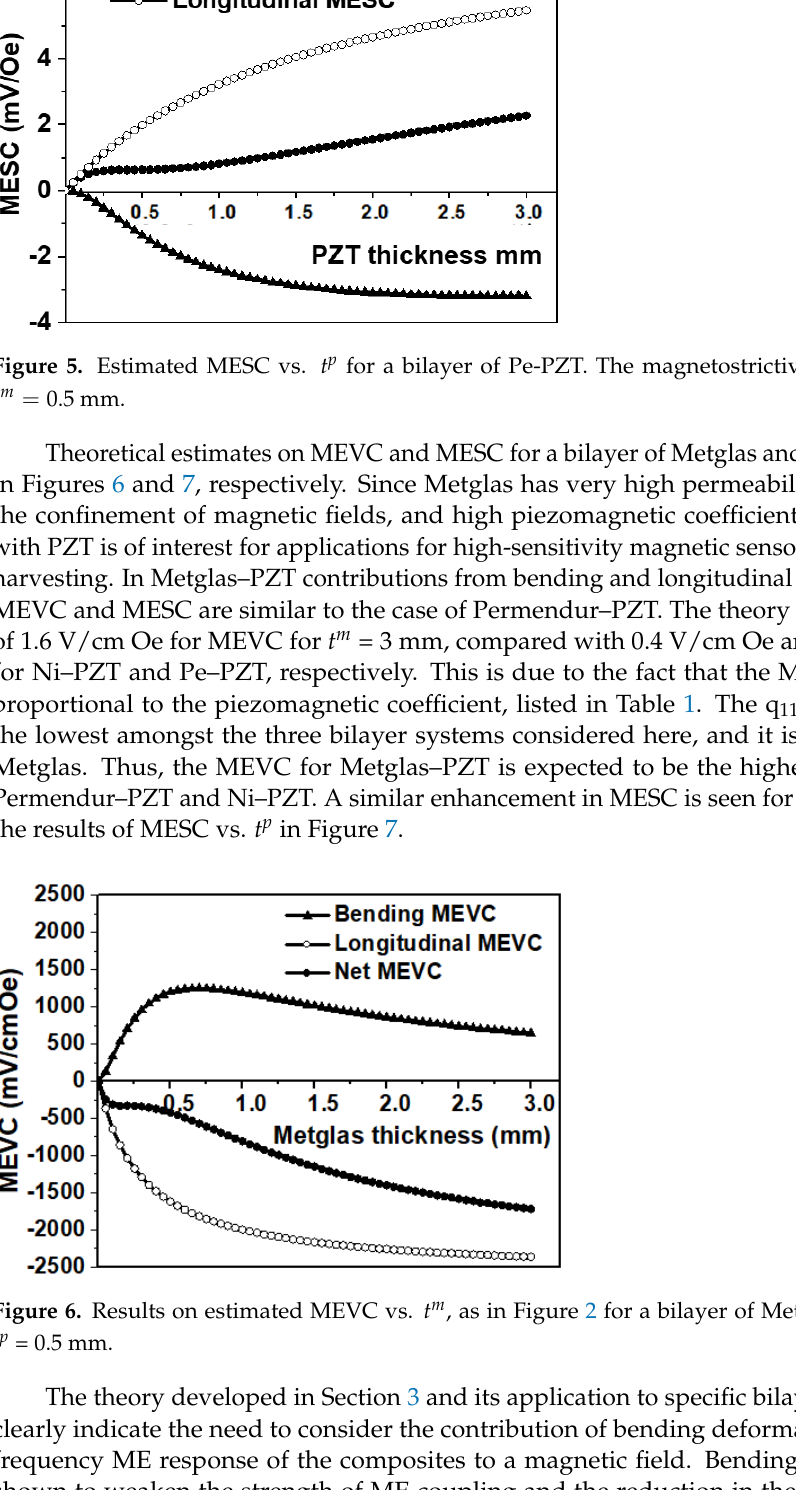
Figure 4. Results on estimated MEVC vs. t m , as in Figure 2 for a bilayer of Permendur (Pe) and PZT for t p = 0.5 mm.